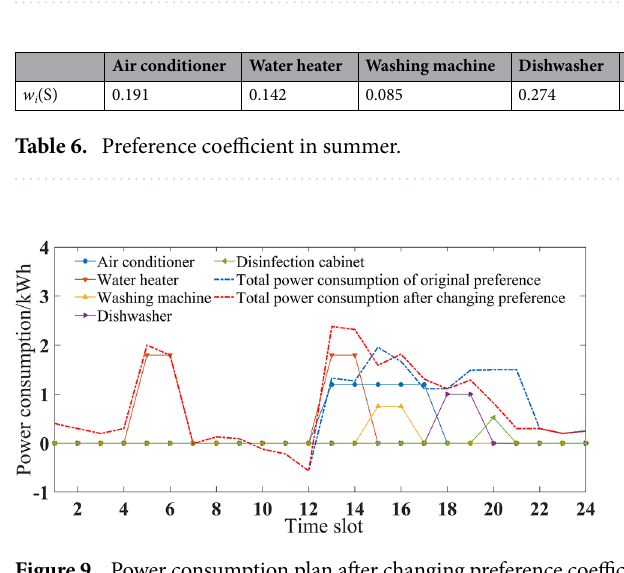
Figure 8. Power consumption plan of multi-objective optimization in winter.